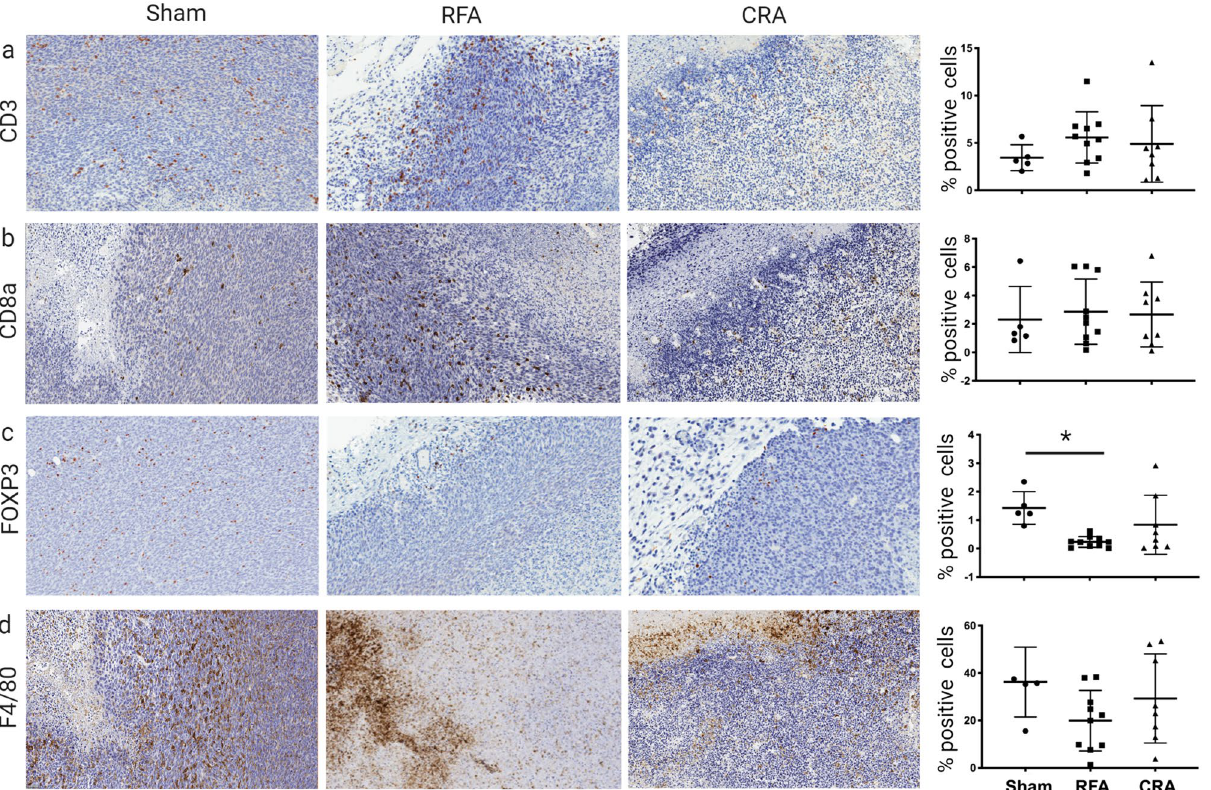
Figure 5. Tumor microenvironment immune infiltrates post ablation. Representative immunohistochemical (IHC) expression of immune infiltrates for sham, radiofrequency ablation (RFA) and cryoablation (CRA) treatment groups: ( a ) CD3, ( b ) CD8a, ( c ) FOXP3 (T-reg), and ( d ) F4/80 (macrophages). The column on the far right represents IHC marker expression levels for each treatment group. Ordinary one-way ANOVA, line at mean with SD, *p < 0.05. Inter-group comparison without an asterisk represents a trend at p = 0.078. Statistical analyses were performed using GraphPad Prism version